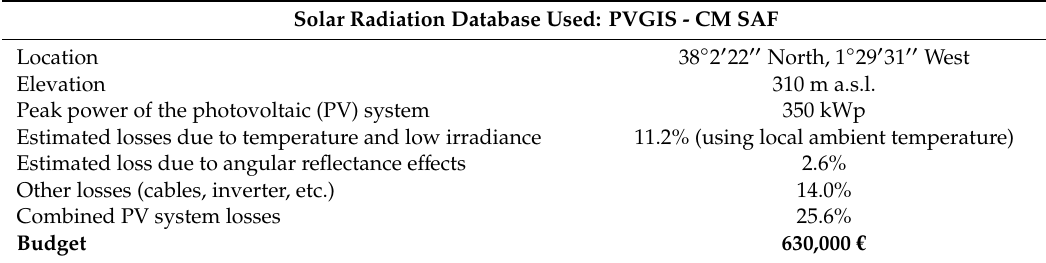
Table 4. Summary of the main data of the photovoltaic installation for the well.